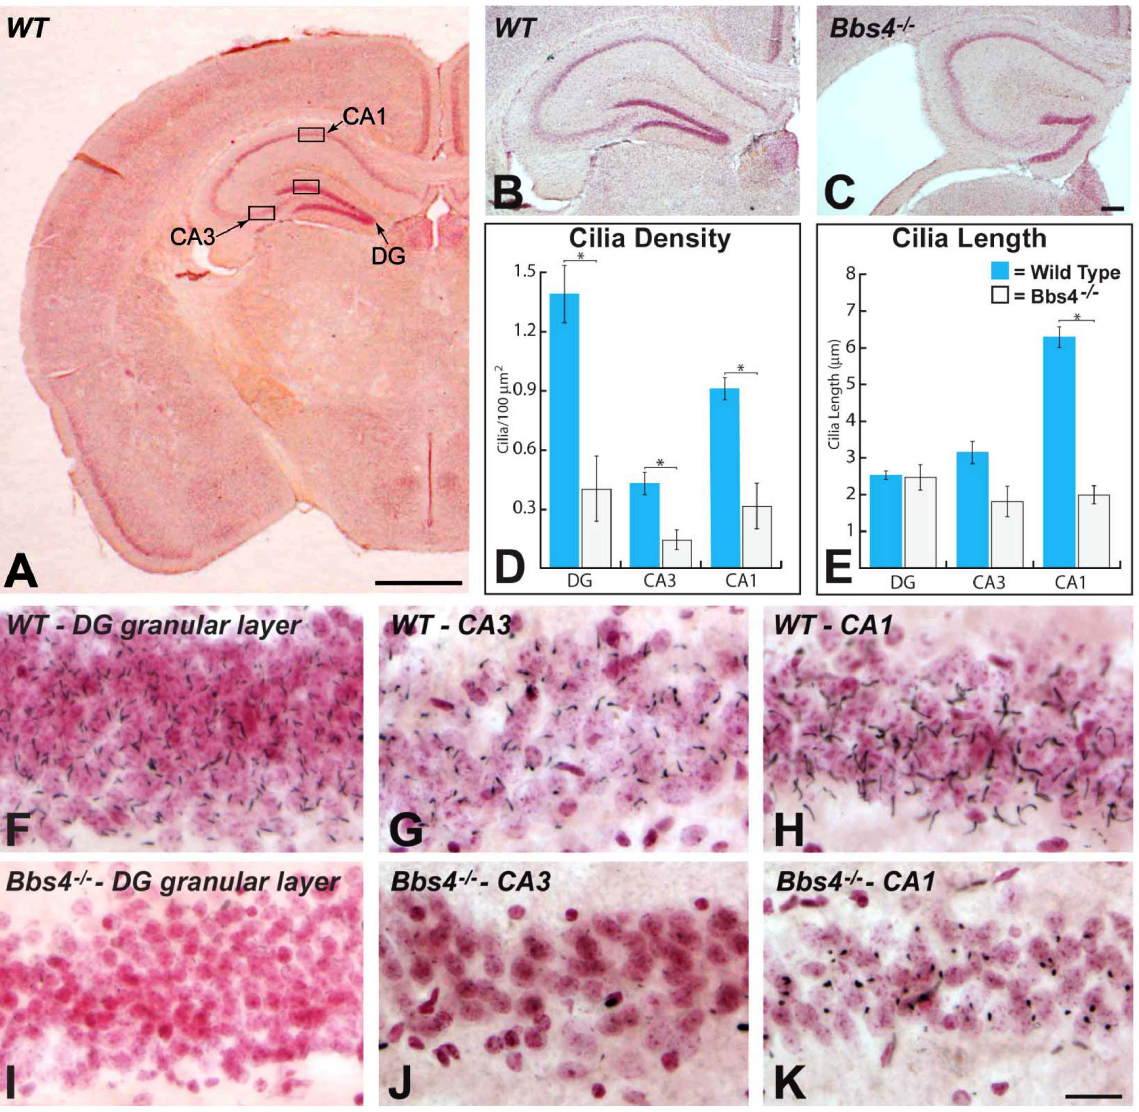
Figure 3. The areas of rostral (dorsal) hippocampus sampled and the distributions of ACIII immunopositive PNC in subdivisions of the hippocampus in WT and Bbs4 -/- mice are illustrated. Figure A shows the subdivisions of hippocampus in coronal plane of chosen in this study for sampling. The boxed areas define the regions in which quantitative data was collected for each area. Figures B and C illustrate the cytoarchitecture of WT (B) and Bbs4 -/- (C) hippocampus at this plane of section. Note the reduction in hippocampal mass and the resulting expansion of the lateral ventricle in Bbs4 -/- mouse brain. Figures D and E illustrates the density of cilia 6 the SEM (D) and length of cilia 6 the SEM within each of the analyzed hippocampal subfields of WT (blue) and Bbs4 -/- (gray) mice; asterisks and brackets indicate where statistical analysis demonstrated statistical differences between WT and Bbs4 -/- mice. The data for (D) and (E) was collected from three WT and five Bbs4 -/- mice. High magnification comparisons of the distribution of cilia within these regions of hippocampus are shown in figures F through K. Note the association of cilia with neurons counterstained with neutral red in each region as well as the dramatic reduction in ACIII + cilia in Bbs4 -/- animals. Cornu Ammonis areas: CA1, CA3 and DG (dentate gyrus). Scale bar in figure A=1 mm, in K=20 m m and figures F – K are of the same magnification.